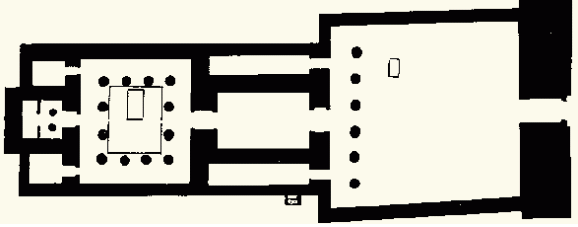
Figure 2. Plan of the temple-tomb of Maya